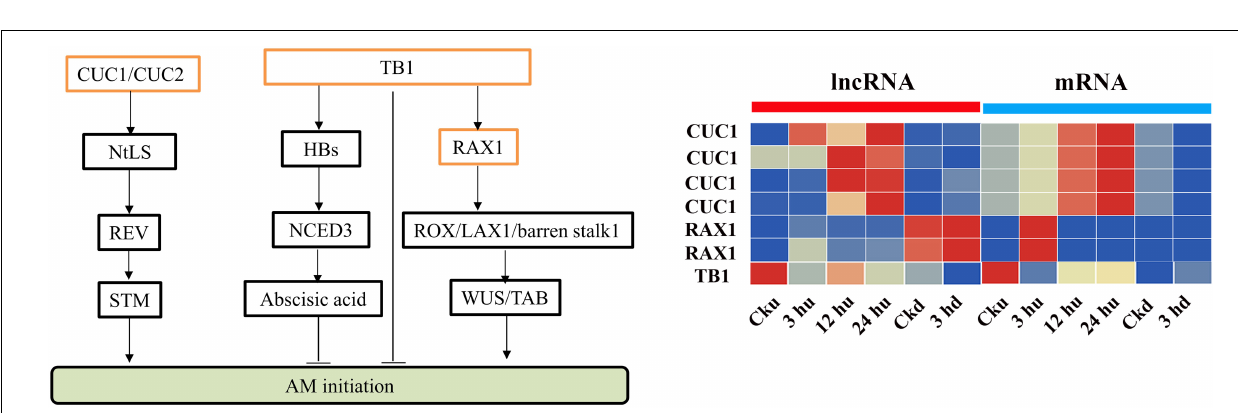
FIGURE 5 | Expression patterns of lncRNAs and mRNAs regulating axillary bud development. All the heatmaps were generated using Tbtools software with log 2 transformed FPKM